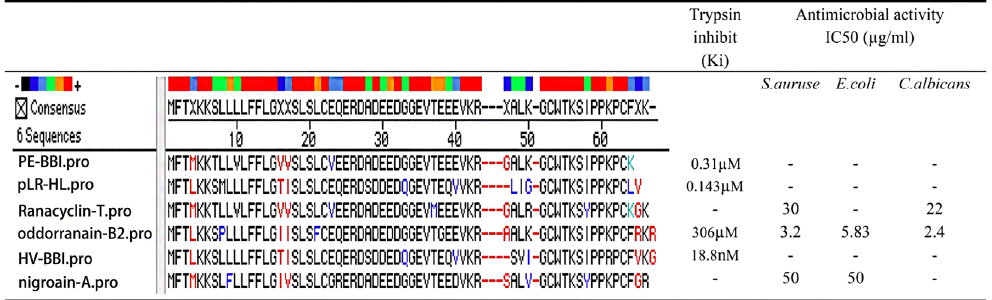
Figure 6. Comparison of different frog skin derived Bowman-Birk-type trypsin inhibitors 18,28–30,32 . “-” means no